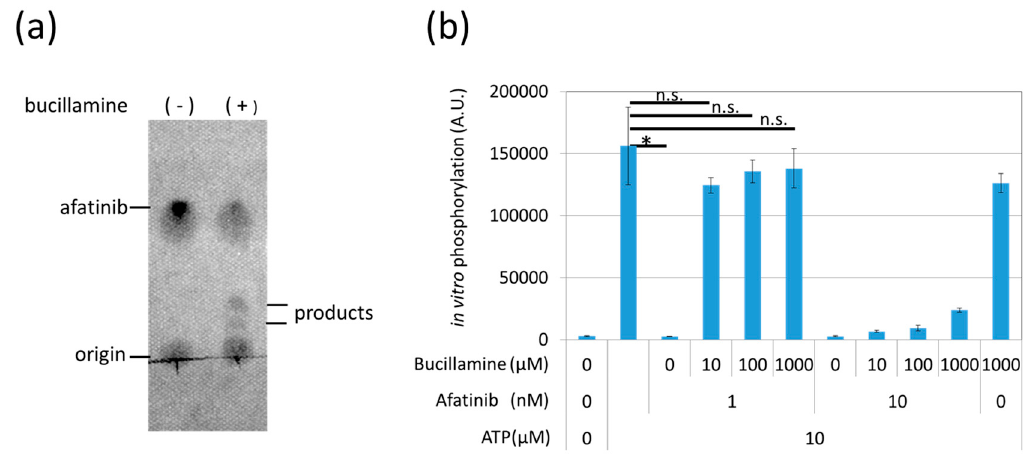
Figure 3. Bucillamine inhibited afatinib-mediated EGFR kinase inhibition in vitro. ( a ) 10 μ M afatinib was incubated with DMSO or 1 mM bucillamine for 90 min at 25 °C. The reaction products were analyzed by TLC with UV detection. ( b ) A recombinant EGFR kinase domain was pre-incubated with 1 or 10 nM afatinib in the presence or absence of 10–1000 μ M bucillamine. Then, 10 μ M ATP was added to the kinase in order to initiate phosphorylation of an artificial substrate peptide. Phosphorylation levels were measured by ELISA using antiphosphotyrosine antibody. The graph indicates the mean ± SEM ( n = at least 3). DMSO, dimethyl sulfoxide; EGFR, epidermal growth factor receptor; TLC, thin-layer chromatography; UV, ultraviolet; ATP, adenosine triphosphate; ELISA, enzyme-linked immunosorbent assay; SEM, standard error of the mean.